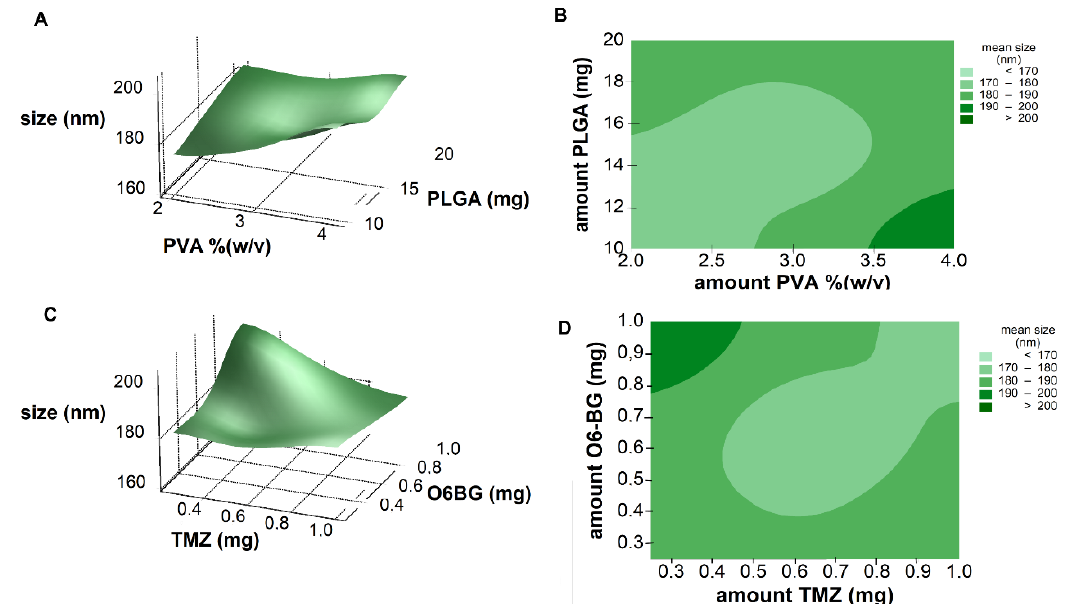
Figure 2. ( A ) Response surface plot and ( B ) contour plot showing the effect of two factors (amount of PVA and PLGA) on the resulting NPs size. ( C ) Response surface plot and ( D ) contour plot